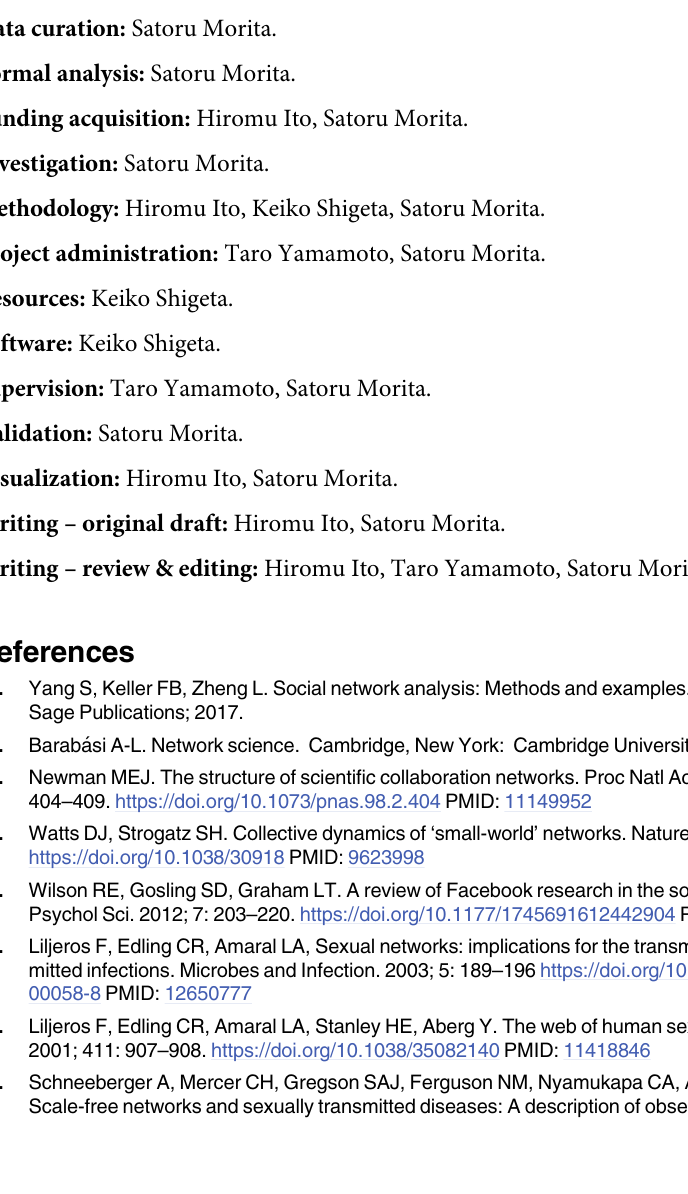
S1 Table. Model selection for degree